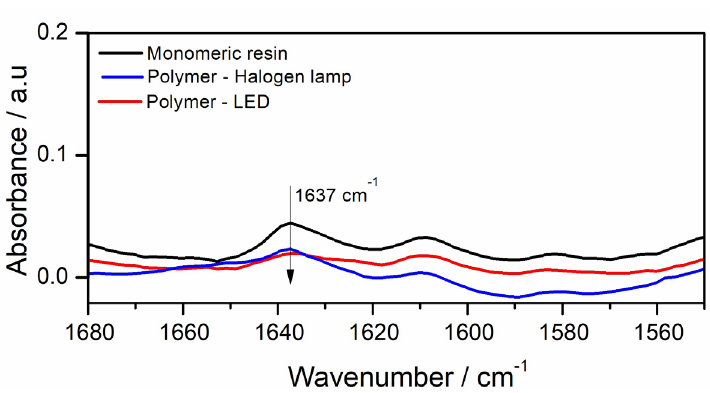
Figure 3. MIR spectra for the monomeric system and polymers.